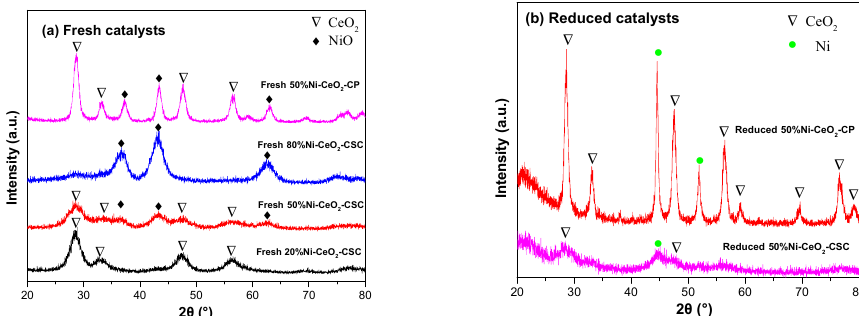
Figure 2. X-ray di ff raction (XRD) patterns of Ni-CeO 2 : ( a ) fresh catalysts, ( b ) reduced Figure 2. X-ray diffraction (XRD) patterns of Ni-CeO 2 : ( a ) fresh catalysts, ( b ) reduced catalysts.